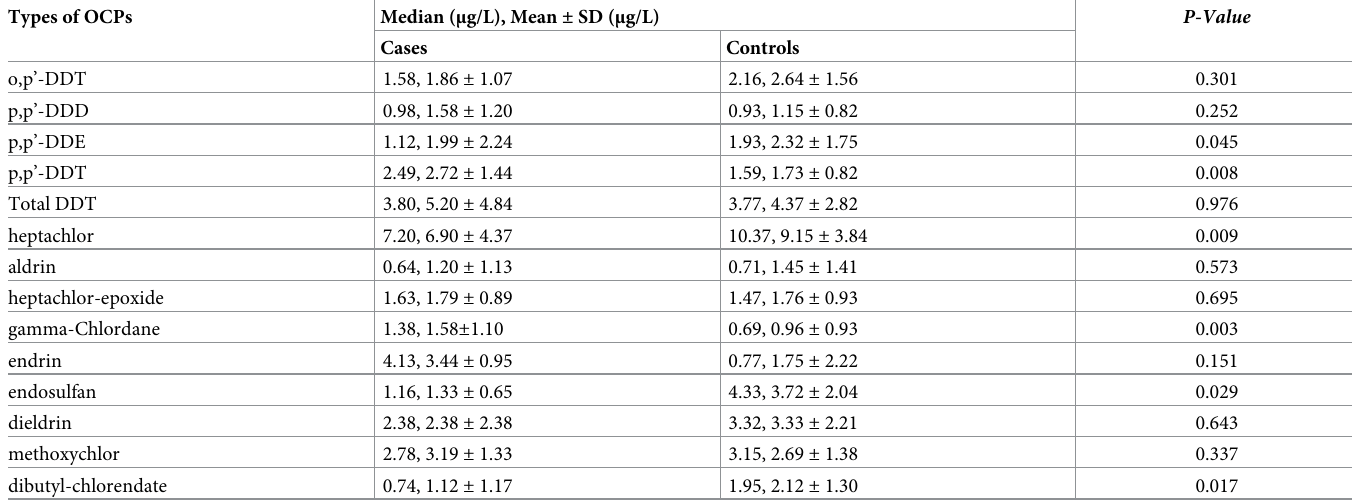
Table 3. Serum concentrations of Organochlorine Pesticides (OCPs) in the study